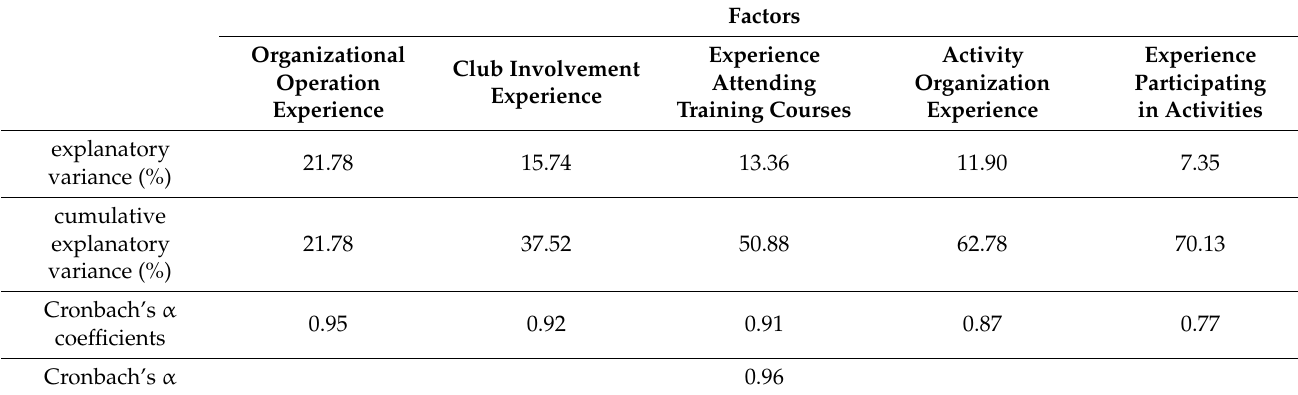
Table 1. Factor Analysis Summary of Learning Experiences in College Clubs.